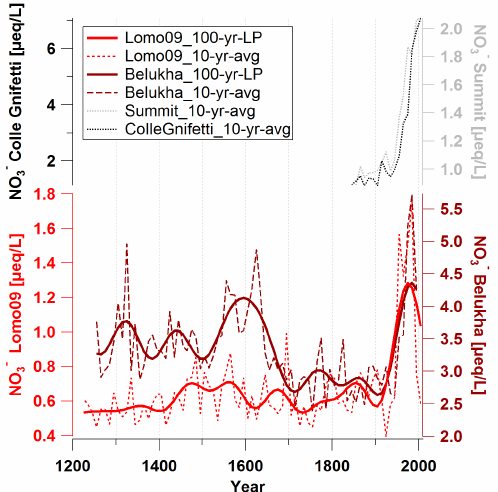
Figure 5. NO − records from Lomo09 (red), Belukha (dark red; 3 Eichler et al., 2009), Summit, Greenland (grey; Geng et al., 2014), and Colle Gnifetti, Swiss Alps (black; Sigl, 2009). Bold lines are 100-year low-pass-filtered (100-yr-LP); dashed lines are 10-year av- erages